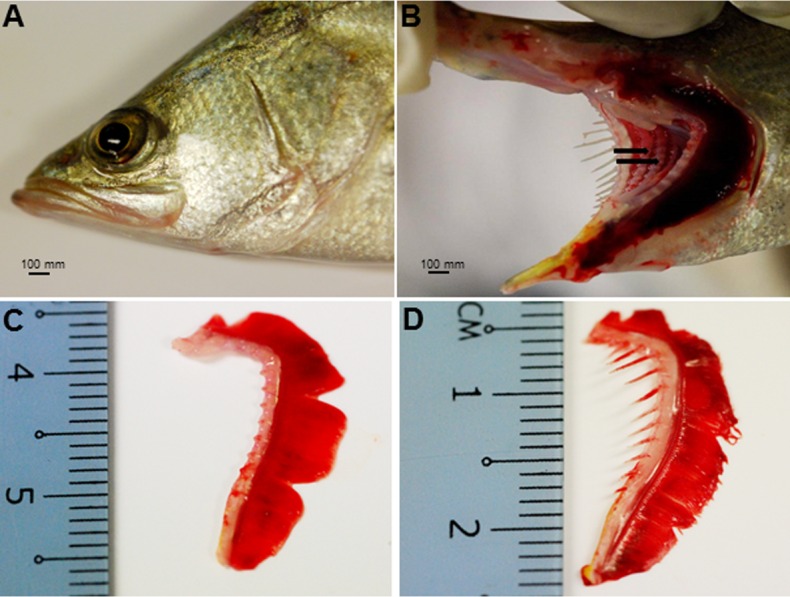
Gross morphology of the Asian seabass head.(A) Head portion of a three-month-old Asian seabass-mouth closed, (B) mouth opened to display the teeth (indicated by black arrows) and (C) the branchial arch without and (D) with gill rakers.